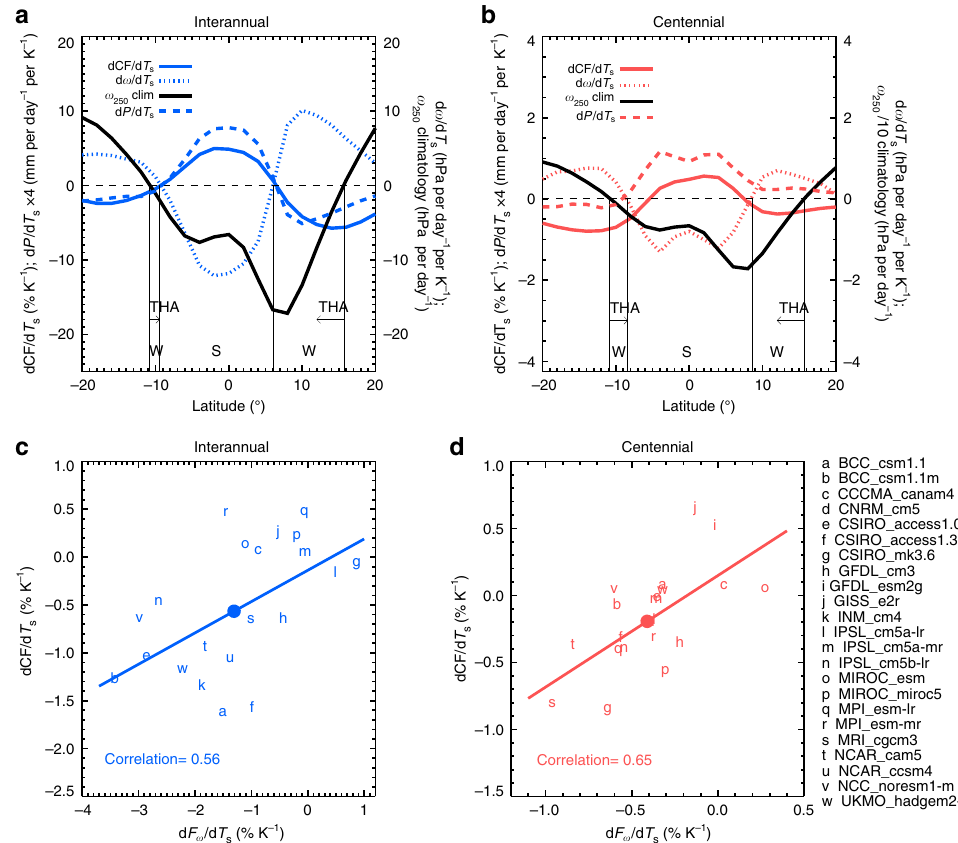
Figure 2 | Relationship between tropical circulation and high CF sensitivities to surface warming. ( a ) Interannual and ( b ) centennial multimodel-mean zonal-mean high CF (solid curves), precipitation (dashed curves) and vertical pressure velocity at 250hPa ( o 250 , signed negative for ascending motion, dotted curves) changes per degree of tropical-mean (20 (cid:2) S–20 (cid:2) N) surface temperature increase. The multiyear-mean o 250 is shown in black solid curves. S and W indicate the strengthening and weakening segments of the Hadley ascent, and THA marks the tightening of Hadley ascent, defined by the weakening of upward motion at the flanks of the intensifying equatorial ascent. ( c ) Interannual and ( d ) centennial tropical-mean high CF change per unit surface warming dCF / d T s scattered against the change of the tropical ascending area fraction per unit surface warming d F o / d T s for 21 CMIP5 models. The tropical ascending area is defined by o 250 o 0Pas (cid:2) 1 . Each model is represented by a lowercase letter. Multimodel means are marked in solid coloured circles. The least-squares linear regression lines and correlation coefficients between the x -axis and y -axis variables are